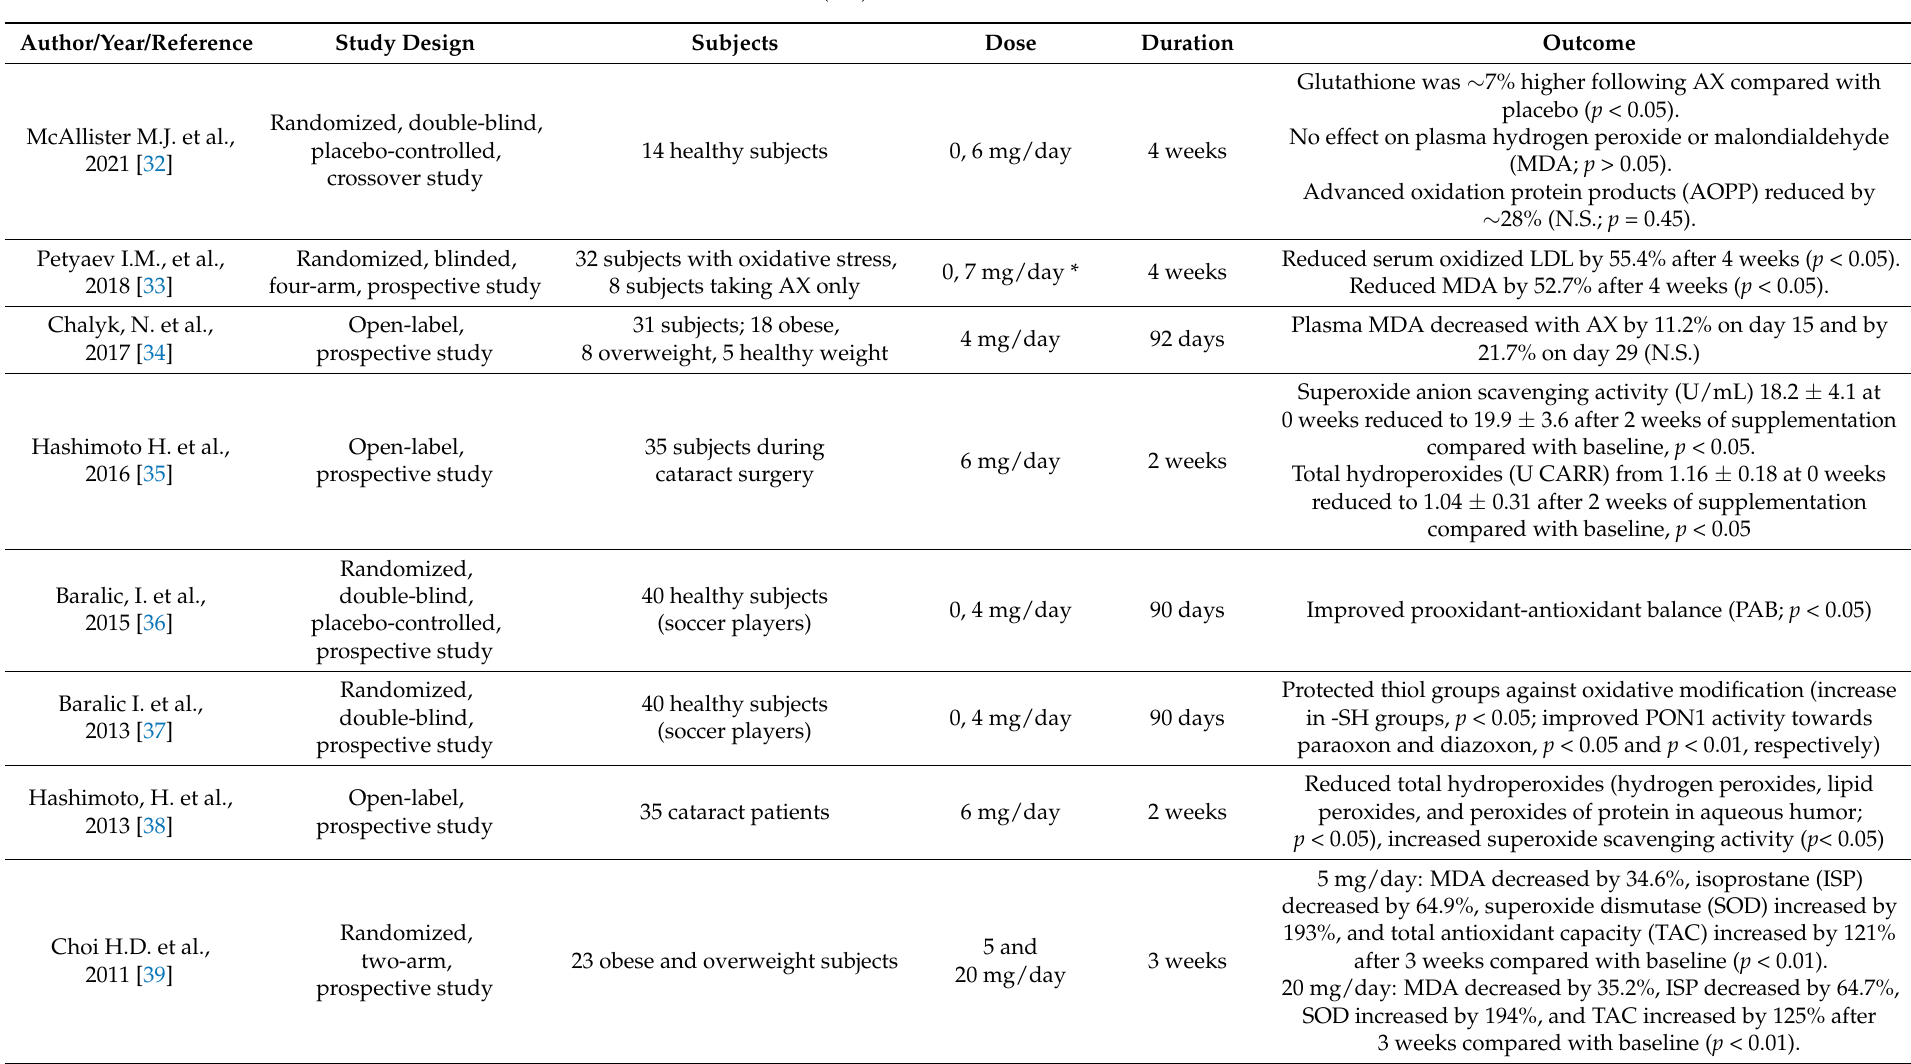
Table 1. Human clinical studies with astaxanthin (AX) that examined oxidative stress